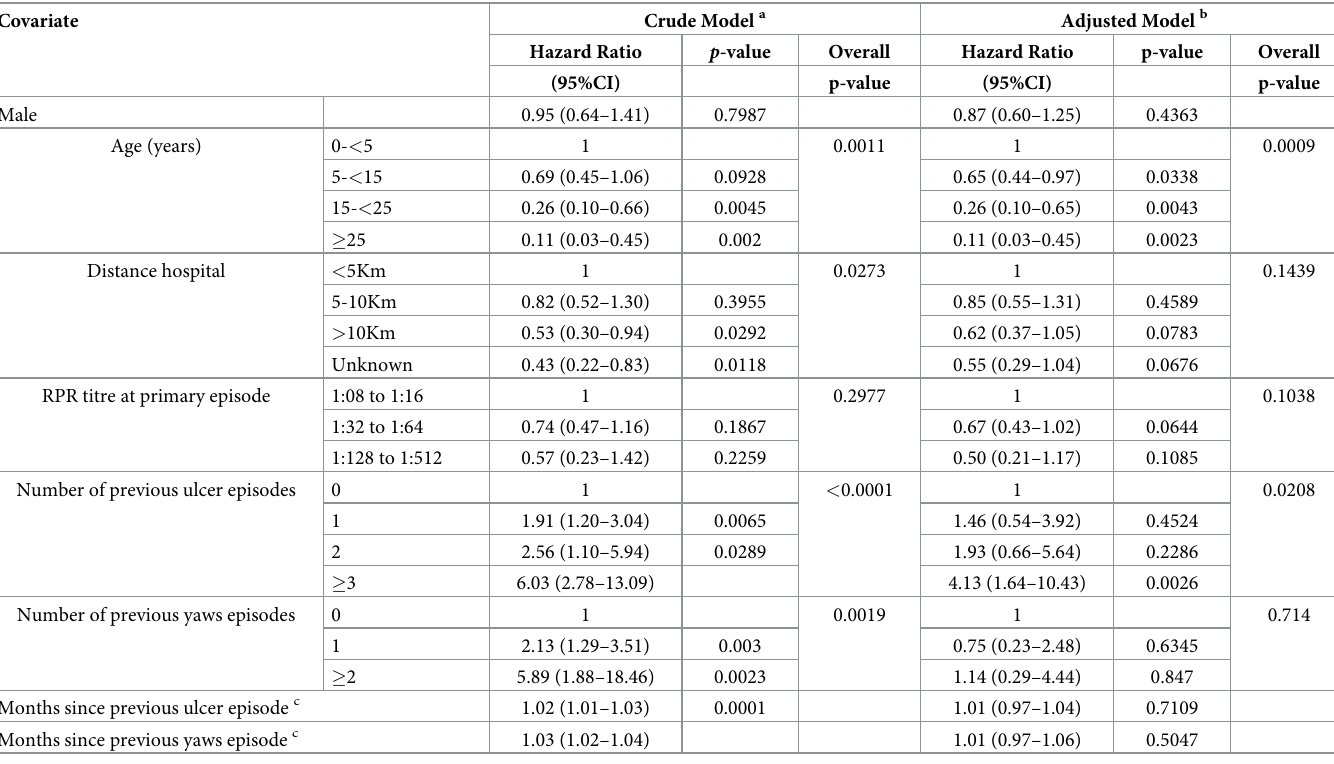
Table 2. Multivariate model for predicting recurrence among patients included in the passive case detection analysis of individuals from electronic health records. Covariate